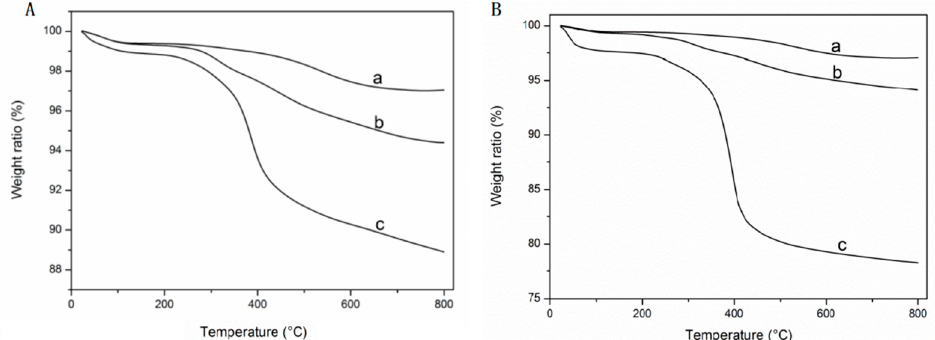
Figure 3. Thermogravimetric analysis curves of different grafted silica. a. NH 2 -grafted silica; b. CTA-grafted silica; c. poly(NIPAAm- co -DEAEMA- co -tBAAm)-grafted silica. ( A ) The grafting density is 30%; ( B ) the grafting density is 50%.